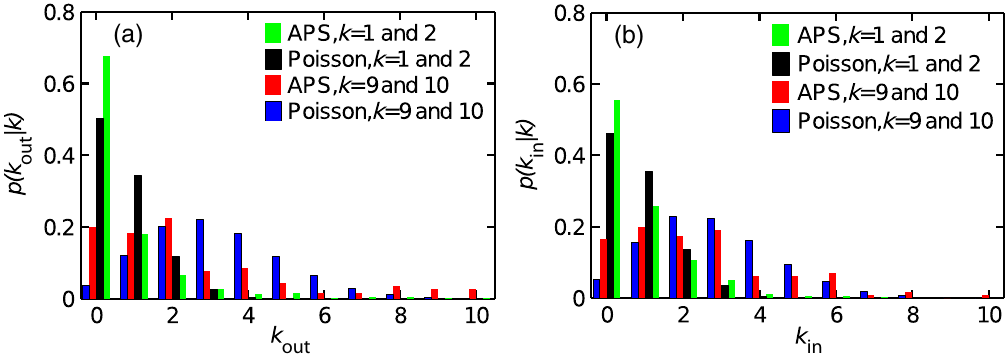
k Þ and (b) P ð k k Þ for the five APS communities. We calculate the probabilities of k out j in j